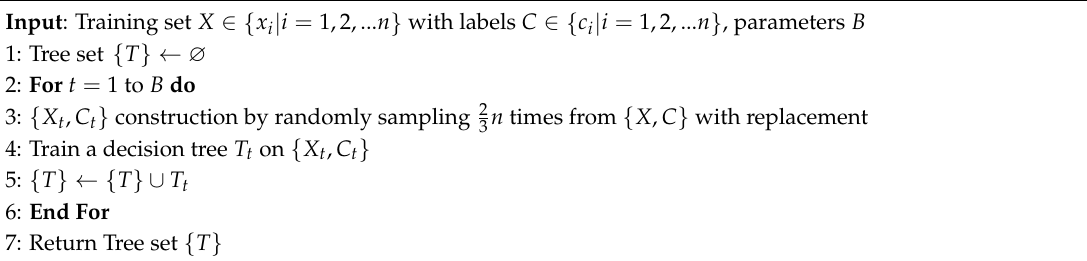
Algorithm 1. Pseudo code for the RF training